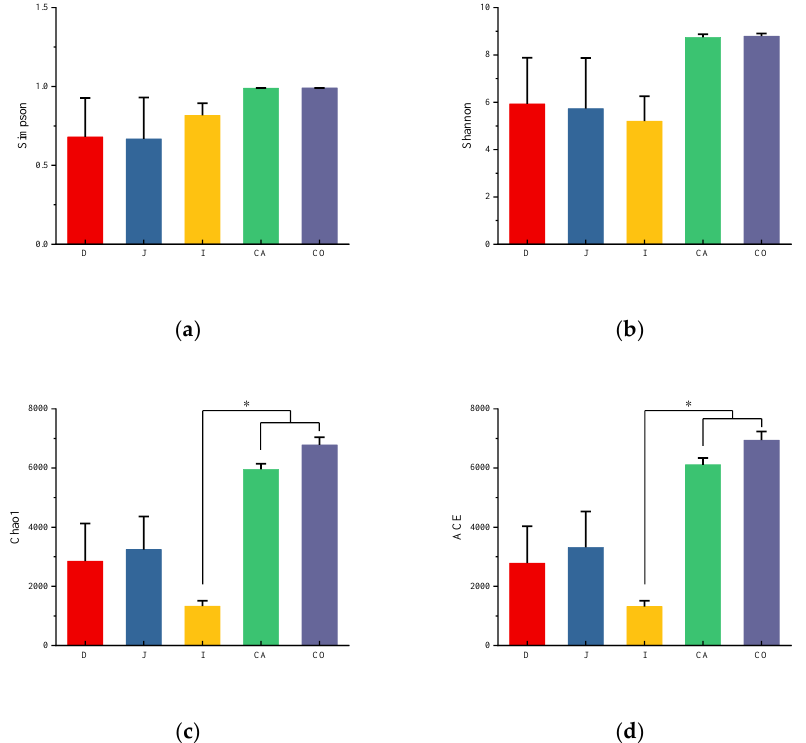
Figure 2. Alpha diversity in different intestinal segments of Hainan black goats. These show the Simpson index ( a ), Shannon index ( b ), Chao1 index ( c ), and ACE index ( d ) of each intestinal segment, respectively. * p < 0.05.